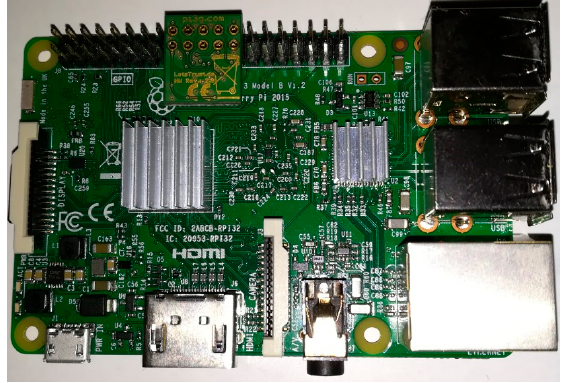
Figure 35. Raspberry Pi 3B+ with LetsTrust TPM v.2.0.